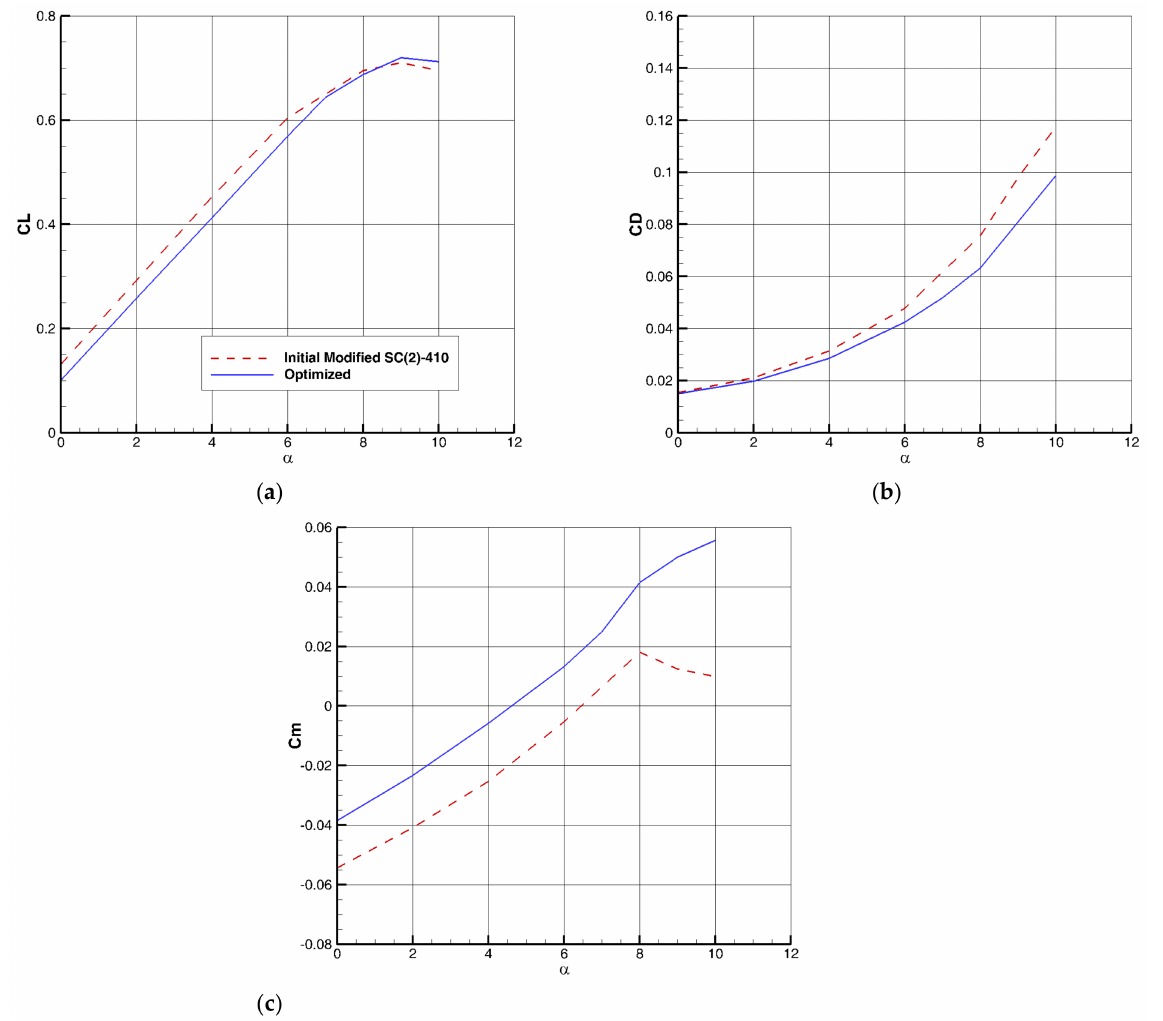
Figure 14. Comparison of the initial and optimized airfoil of wing-body in the presence of PVG in